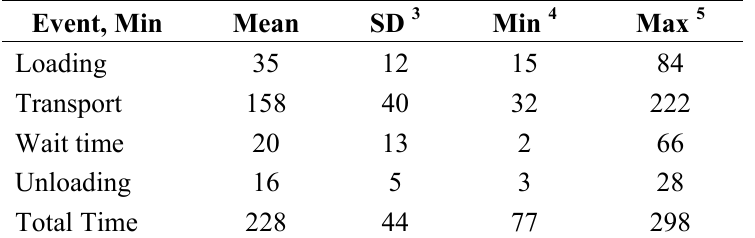
Table 3. Experiment 1. Descriptive statistics for transport events 1 for market weight pigs 2